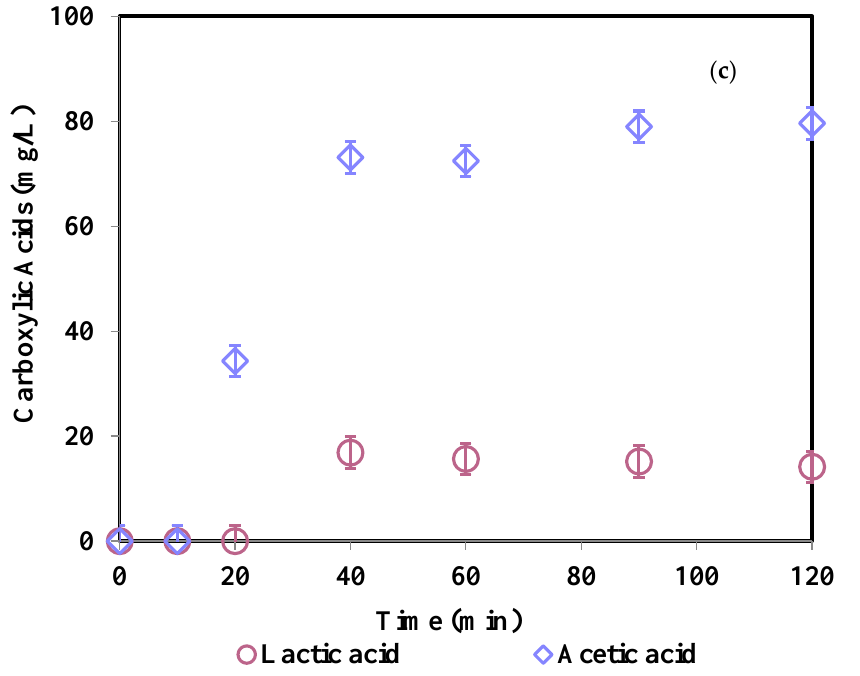
Figure 7. Changes in IPR and DOC ( a ), hydroquinone ( b ) and carboxylic acids ( c ) concentrations during ZVI/PS treatment. IPR = 10 mg/L; PS = 2.50 mM; ZVI = 1 g/L; pH = 3.0.